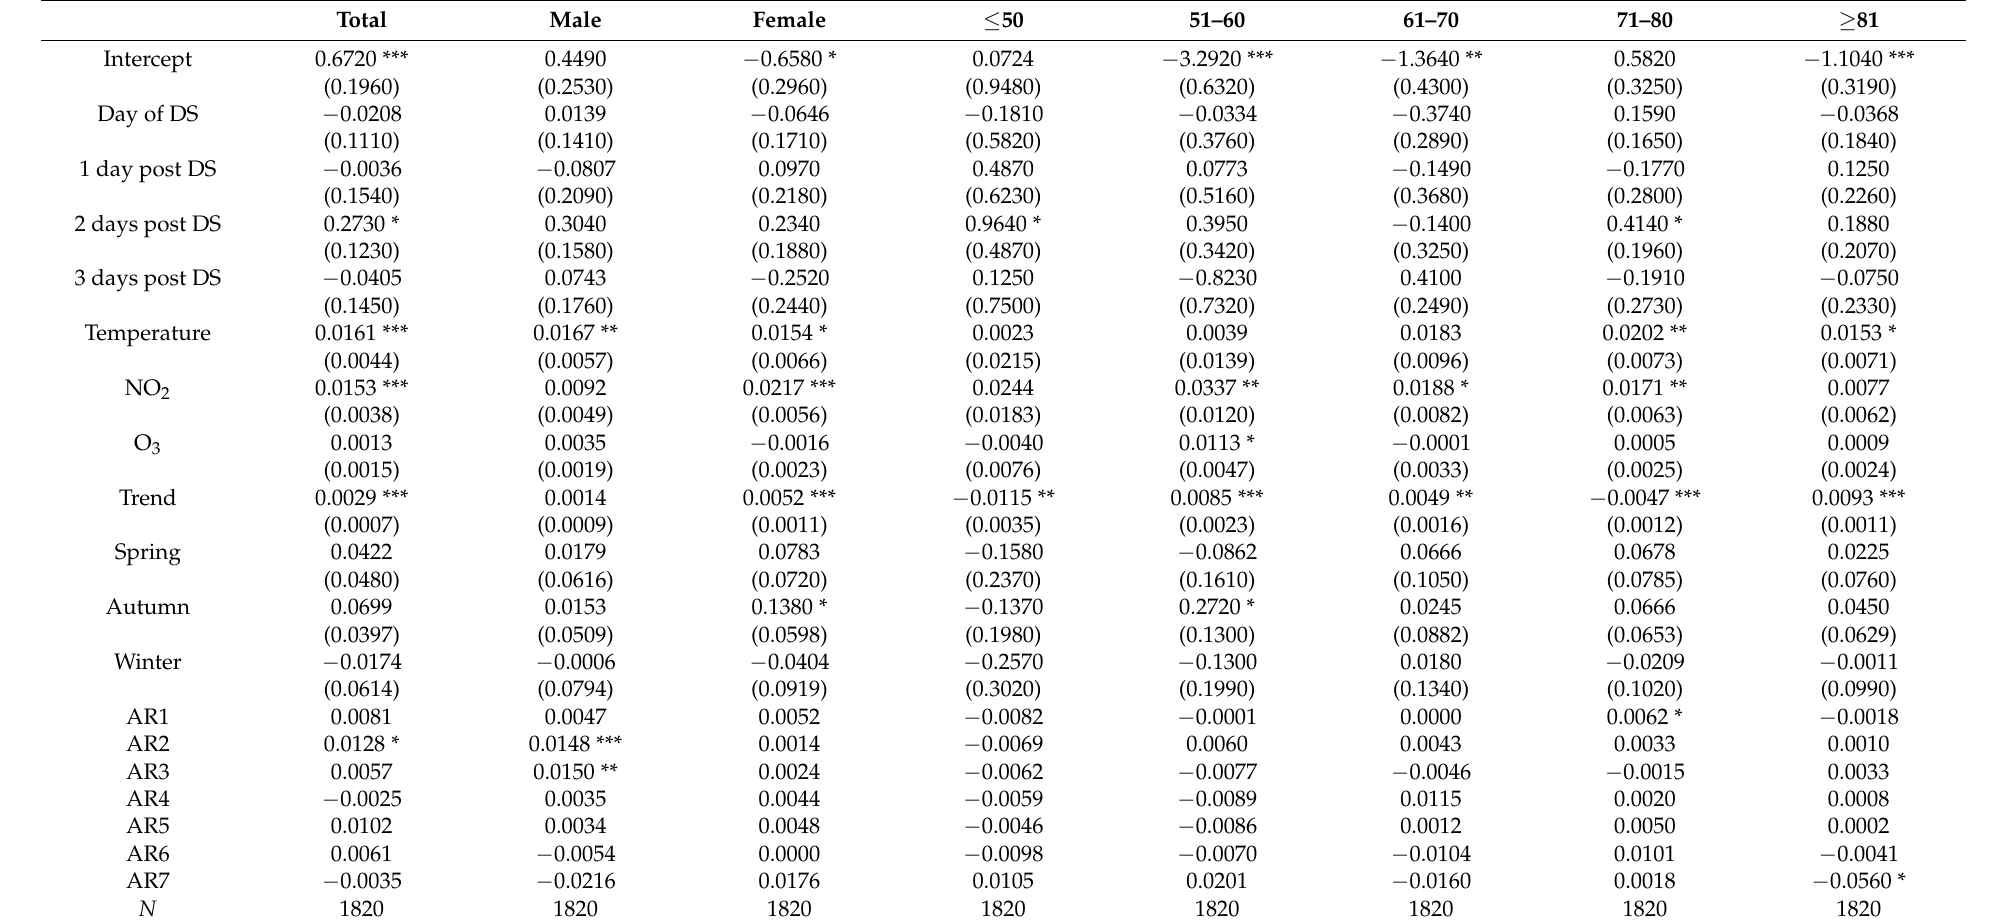
Table 4. Poisson autoregressive analysis for dry AMD outpatient